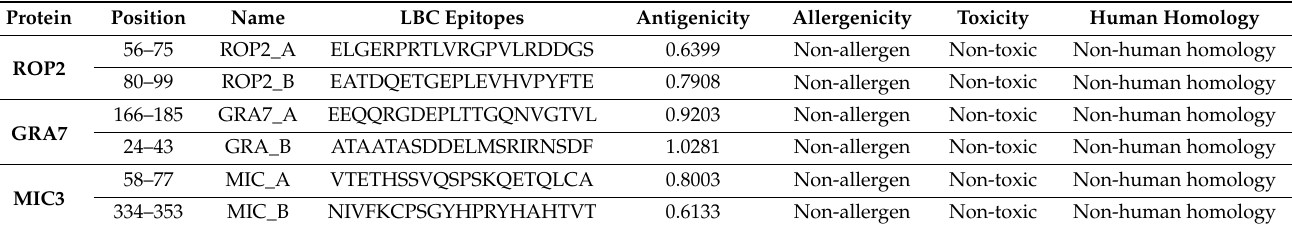
Table 1. LBL epitopes selected for vaccine